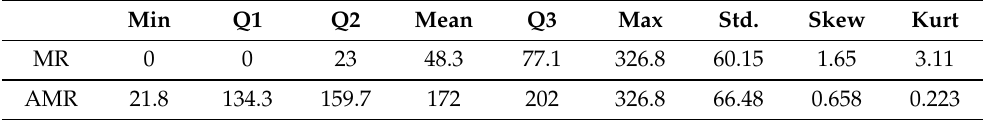
Table 2. Summary statistics of the monthly rainfall (MR) and annual maximum rainfall (AMR). Min Q1 Q2 Mean Q3 Max Std. Skew Kurt MR 0